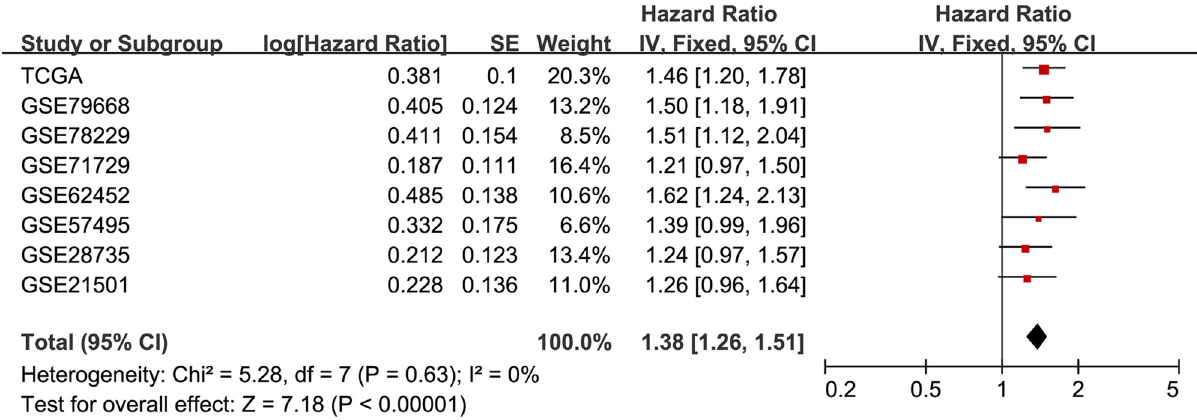
Figure 4: The forest plot indicating the prognostic value of ITGA3 in pancreatic cancer. CI, con fi dence interval. SE, standard deviation.